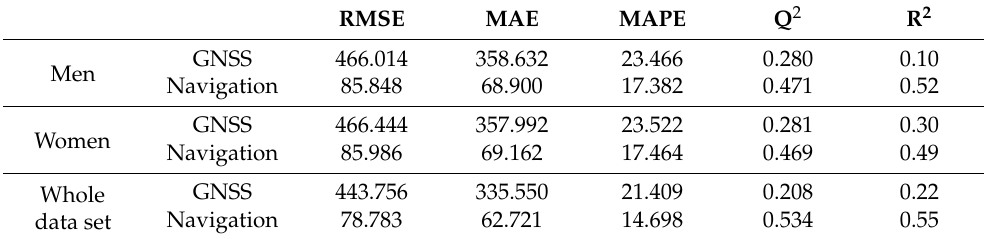
Table 3. Error measures on the models under study, Q 2 and R 2